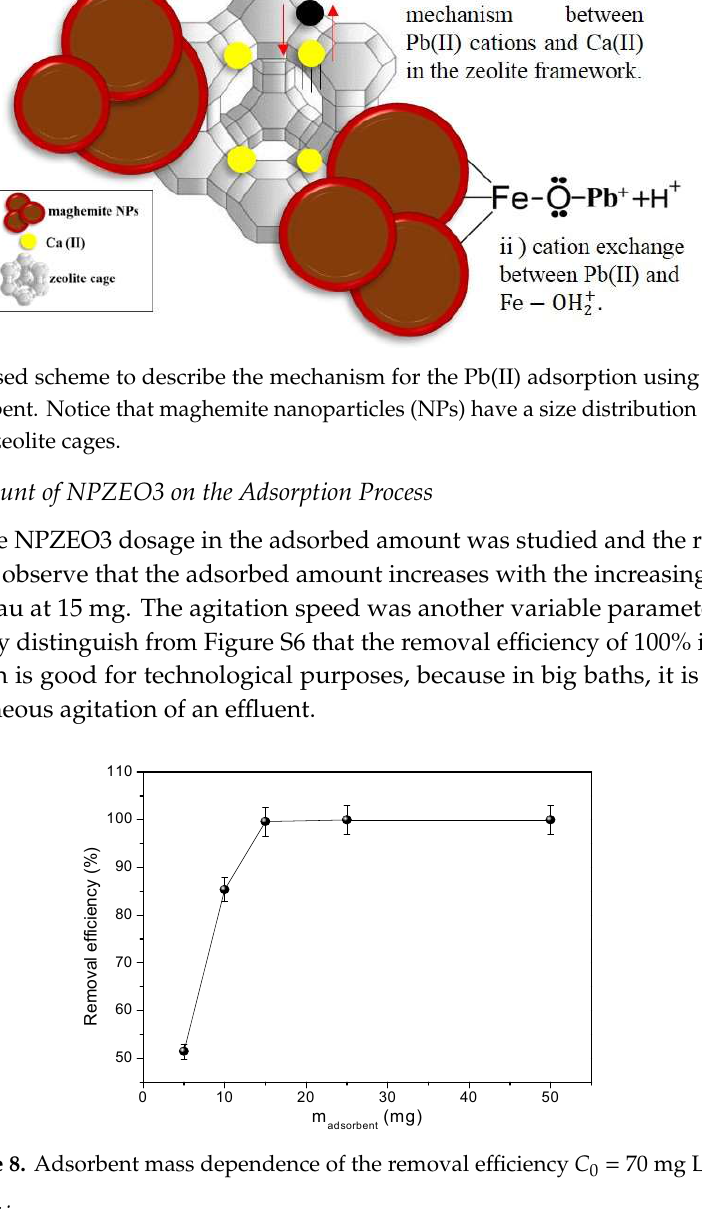
Figure 9. Time dependence of Pb(II) adsorption capacity for the zeolite type 5A ( a ) and NPZEO3 ( b ). The insets show the data fitted to the pseudo kinetic order model. Intraparticle diffusion model ( c )